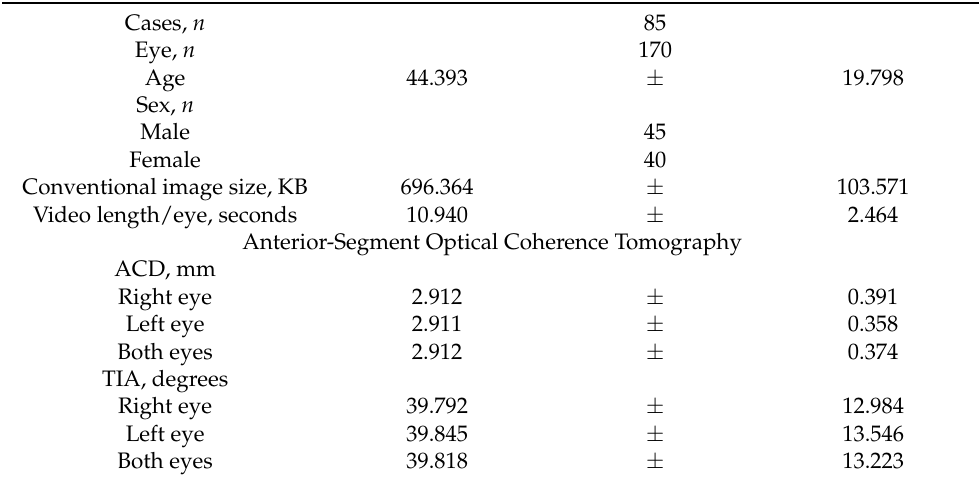
Table 1. Patients’